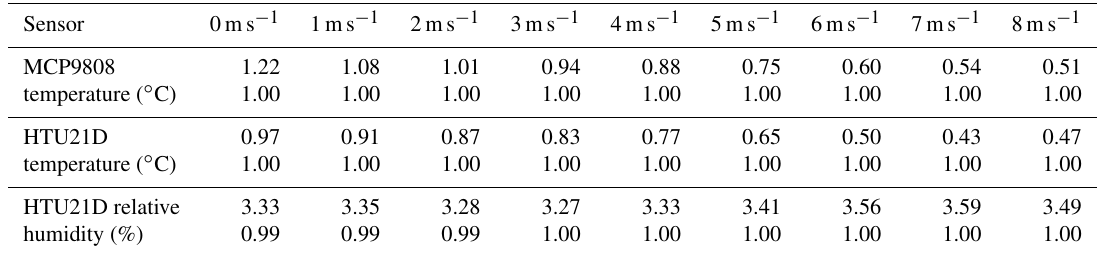
The date indicated in the first row is the start date of the period used in the analysis. Table 5. 3D weather station temperature RMSE (top value) and correlation coefficient (bottom value) response to increased wind speed